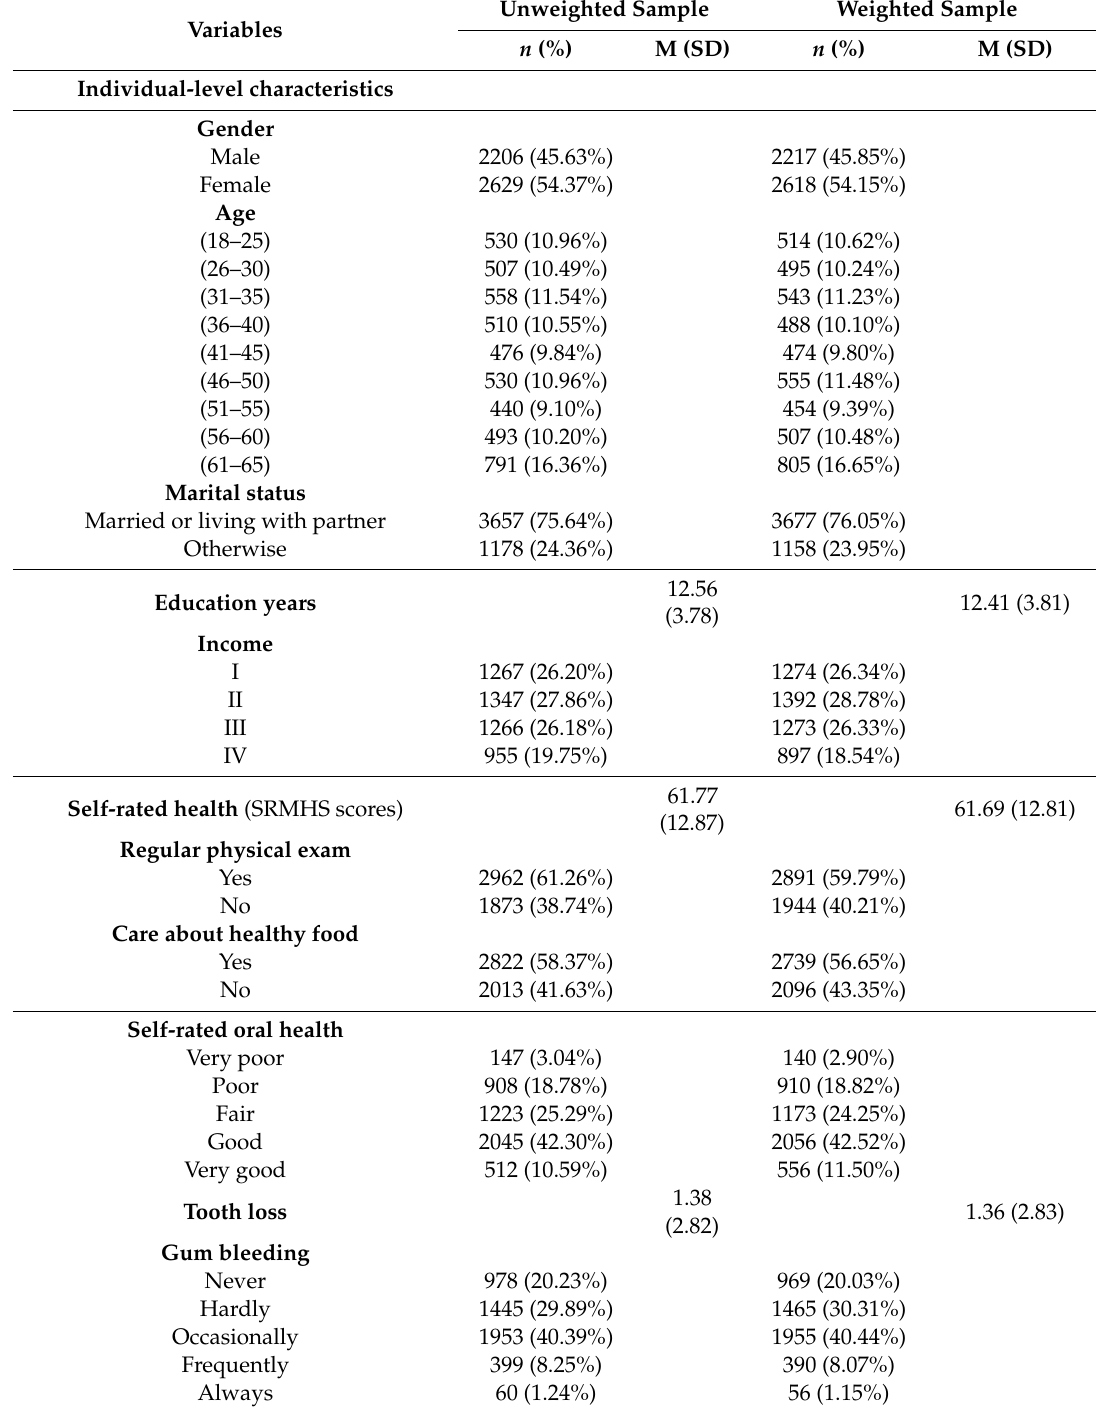
Table 1. Sample characteristics ( n = 4835, unweighted and